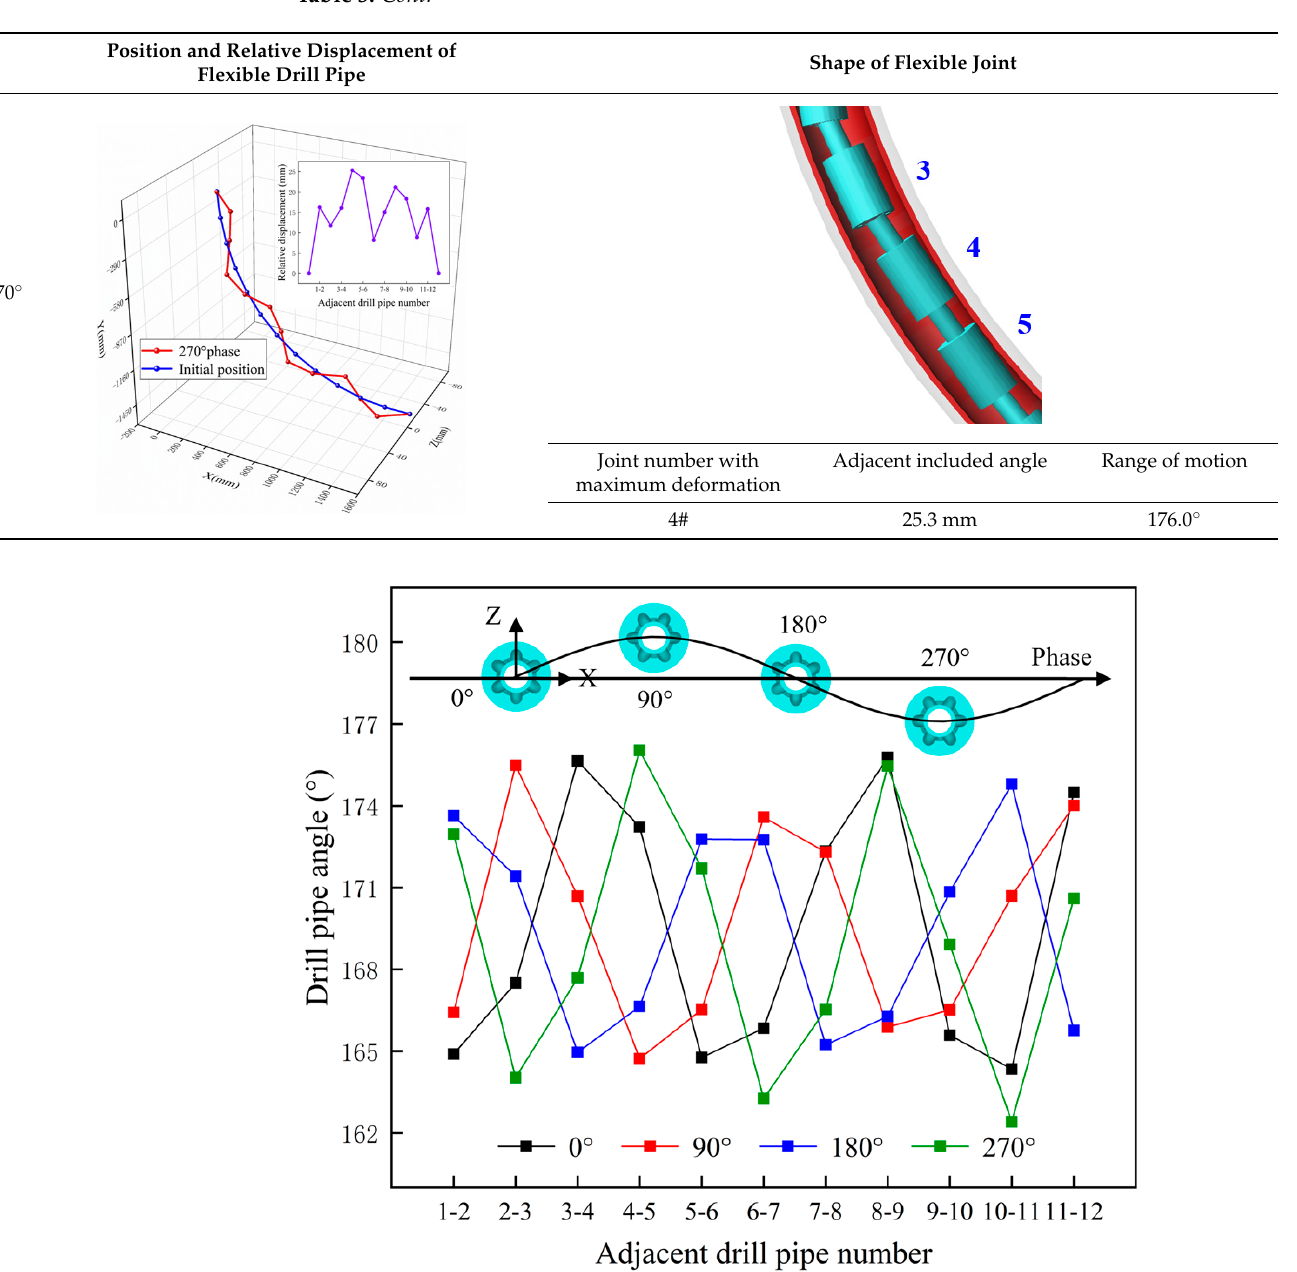
The flexible joint collides with the guide tube and makes frictional contact during the